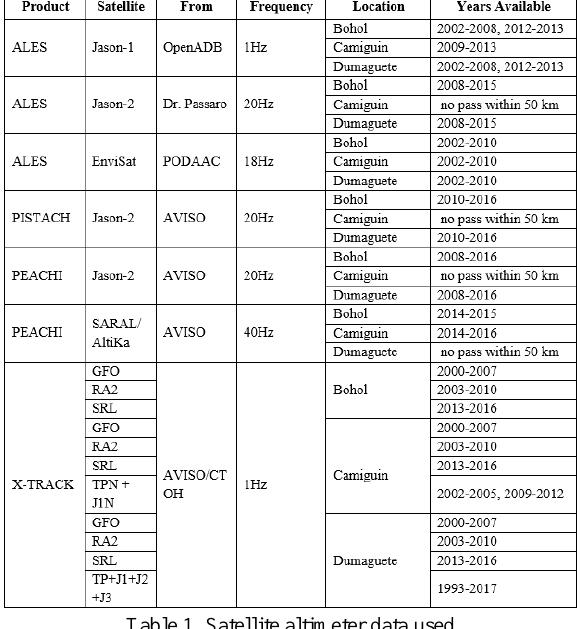
Table 1. Satellite altimeter data used